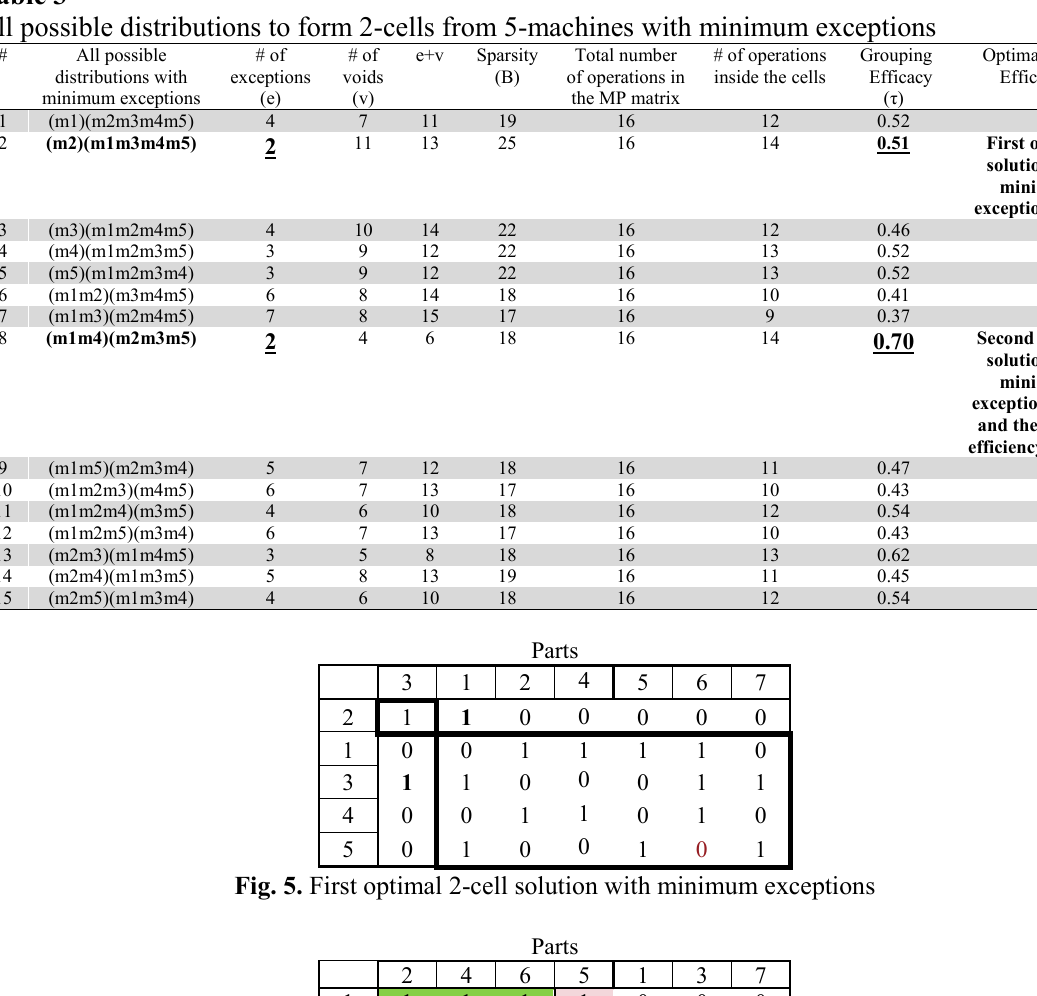
All possible distributions to form 2-cells from 5-machines with minimum exceptions